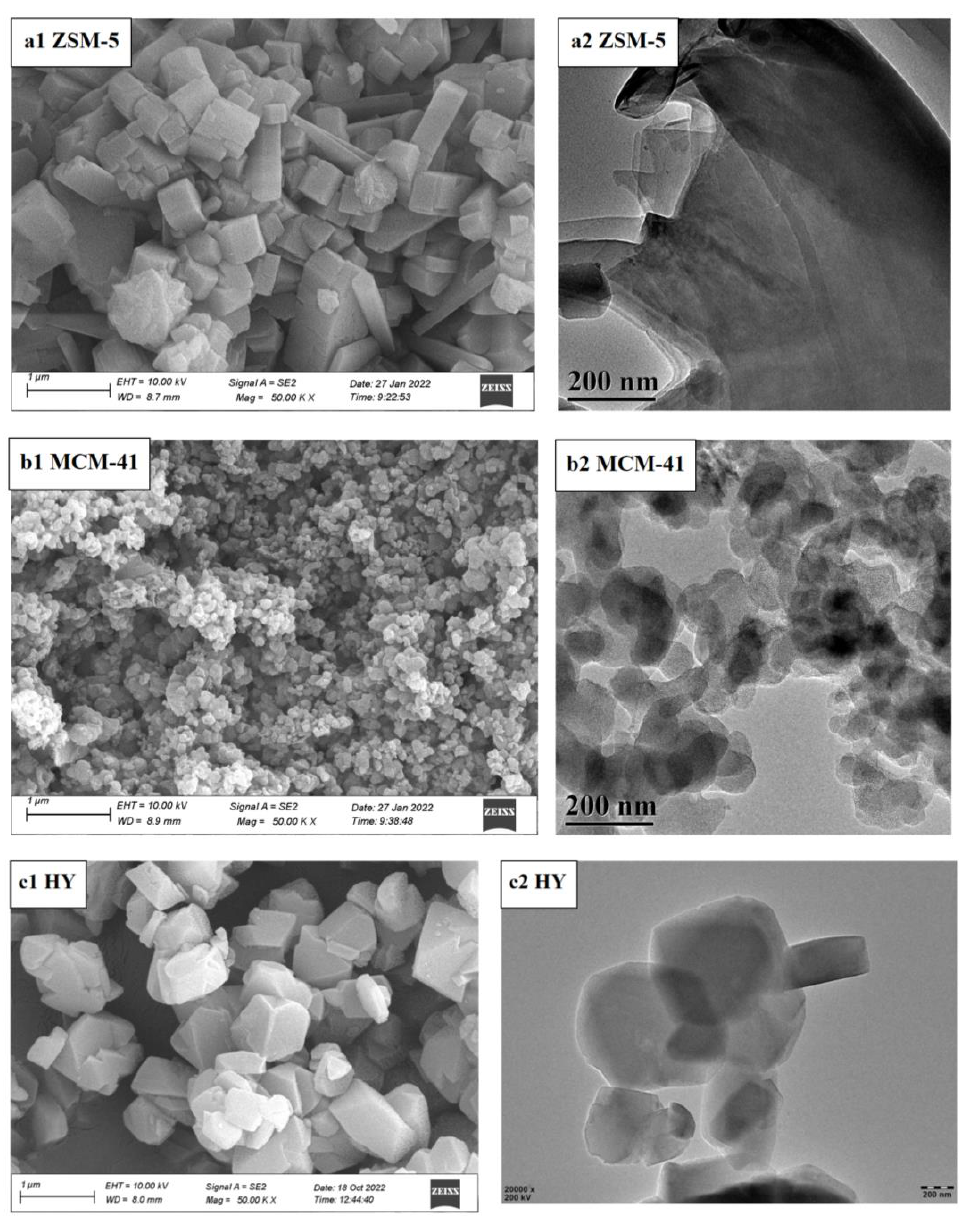
Figure 2. The SEM and TEM images of three kinds of catalysts. ( a1 , b1 , c1 ): SEM; ( a2 , b2 , c2 ): TEM.